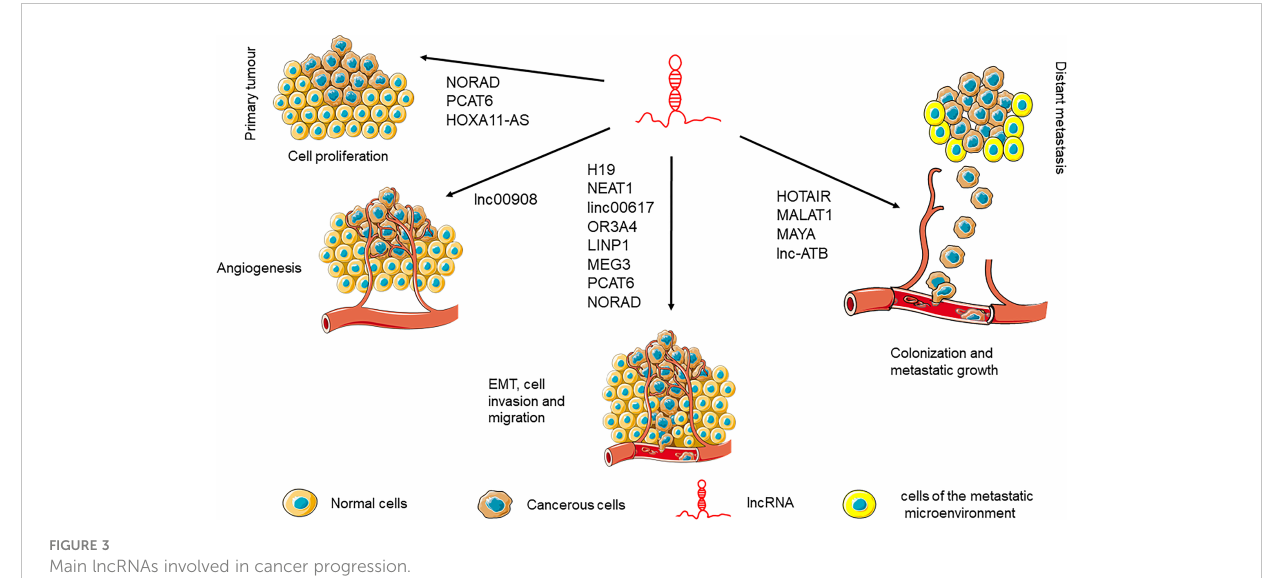
FIGURE 3 Main lncRNAs involved in cancer